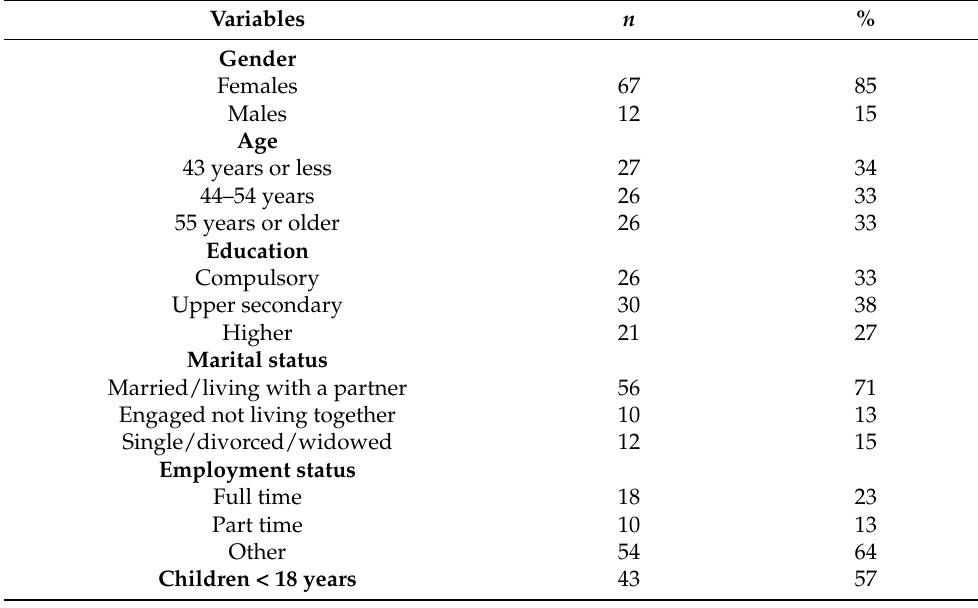
Table 1. Description of sociodemographic variables ( n = 79).